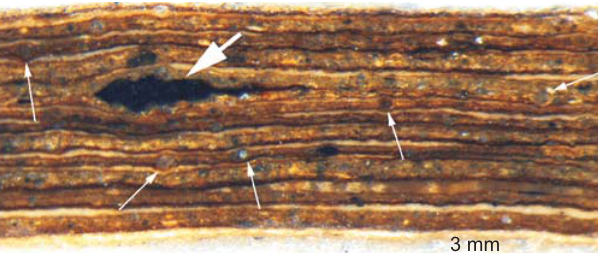
Fig. 9. Rhythmite structure of Park site oil shale (USNM 595137) from the Coal Creek member of the Kishenehn Formation, Eocene, Montana, USA, that is a source of numerous small (<10 cm) fish fossils. Note the dark colored, organic-rich sapropelic nature of the shale and the small clastic (small arrows) and large (large arrow) organic inclusions.